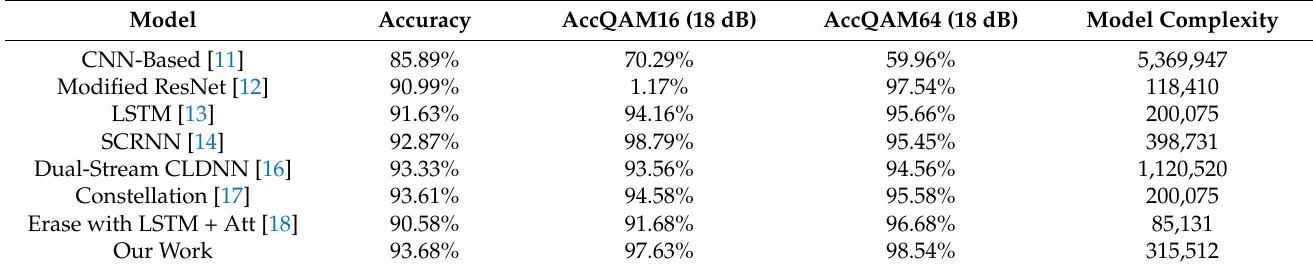
Figure 15. Comparison of space complexity of different models [11–14,16–18]. Table 3. Comprehensive comparison of the results of different models.